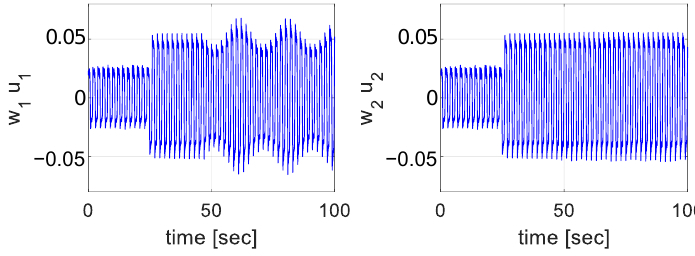
Figure 20. Control signals ( 𝑢 1 , 𝑢 2 ): ( a ) t = 0~100 s, ( b ) t = 40~70 s.